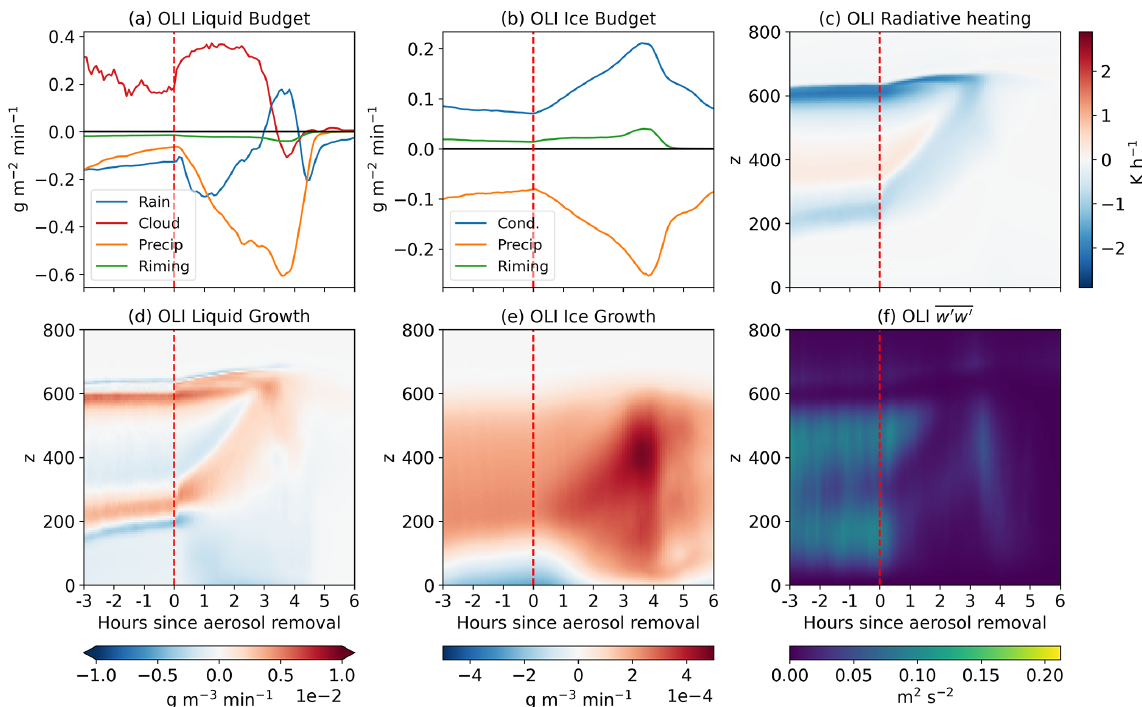
Figure 7. Vertically integrated domain-averaged budgets for (a) condensational growth of liquid hydrometeors (Rain; Cloud), removal by accumulation of liquid precipitation at the surface (Precip) and riming (Riming). (b) Growth of all ice species by condensation (Cond), riming (Riming), and removal by accumulation of ice precipitation at the surface (Precip). Additionally, 2D (time/height) (c) radiative heating/cooling, growth of (d) liquid and (e) ice, and (f) vertical momentum flux for OLI. The red line denotes the time of aerosol